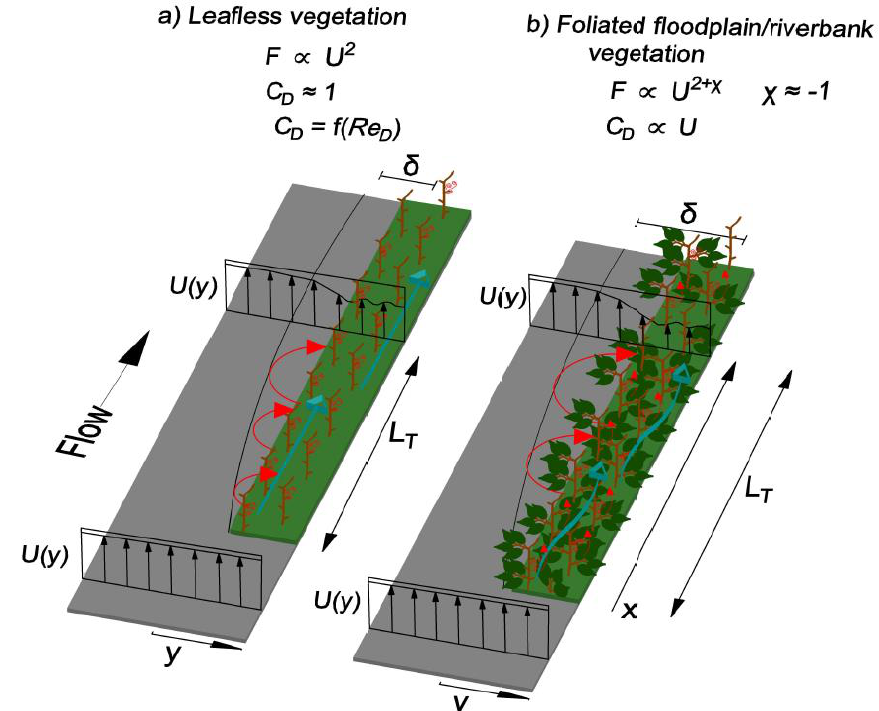
Figure 2. Conceptual view of a partly vegetated channel with ( a ) leafless floodplain / riverbank